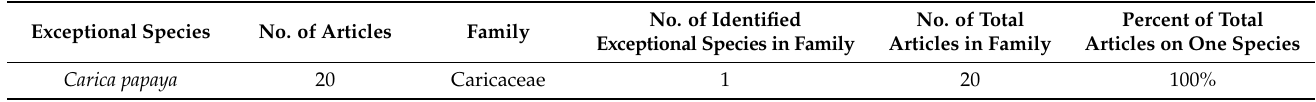
Table 5. Exceptional species listed in the current Working List of Exceptional Plants, which were found in five or more articles in the Web of Science literature